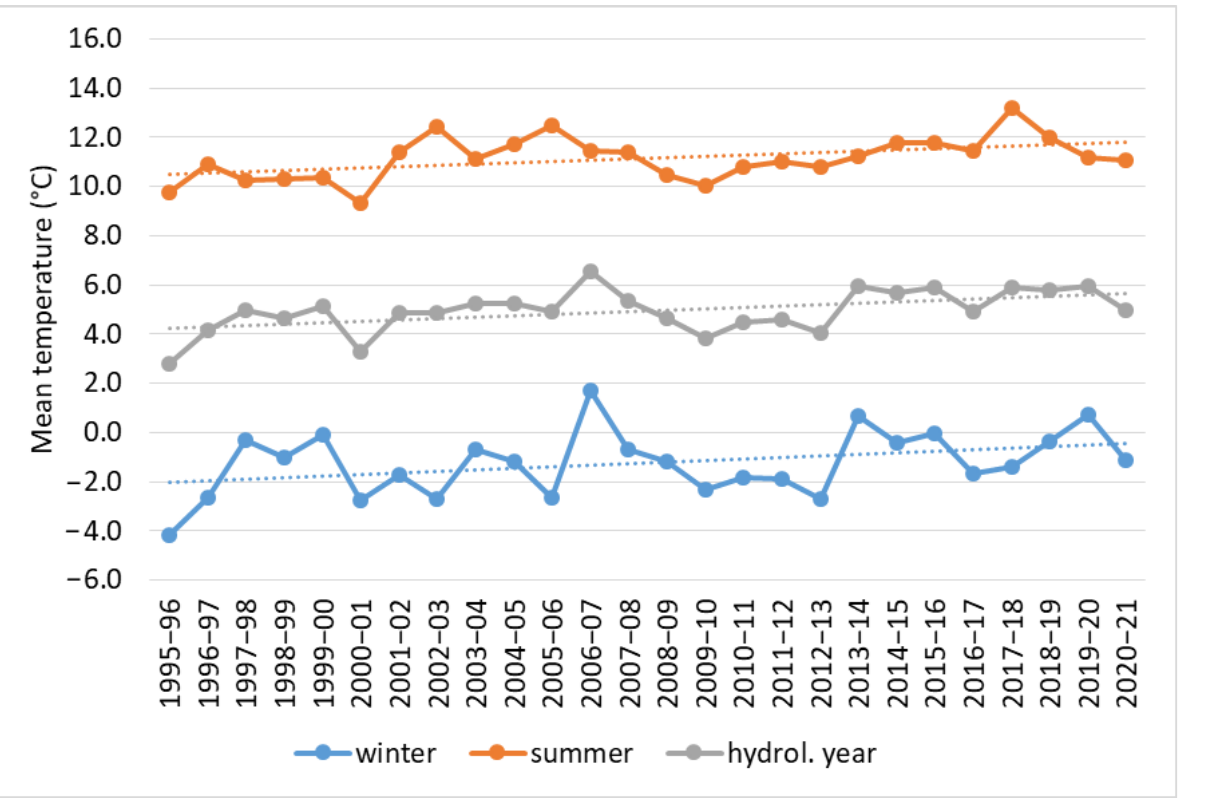
Figure 7. Average temperatures on the experimental catchment UDL with linear trends. Regression slope: winter p = 0.07, summer p = 0.01, hydrological year p = 0.006.